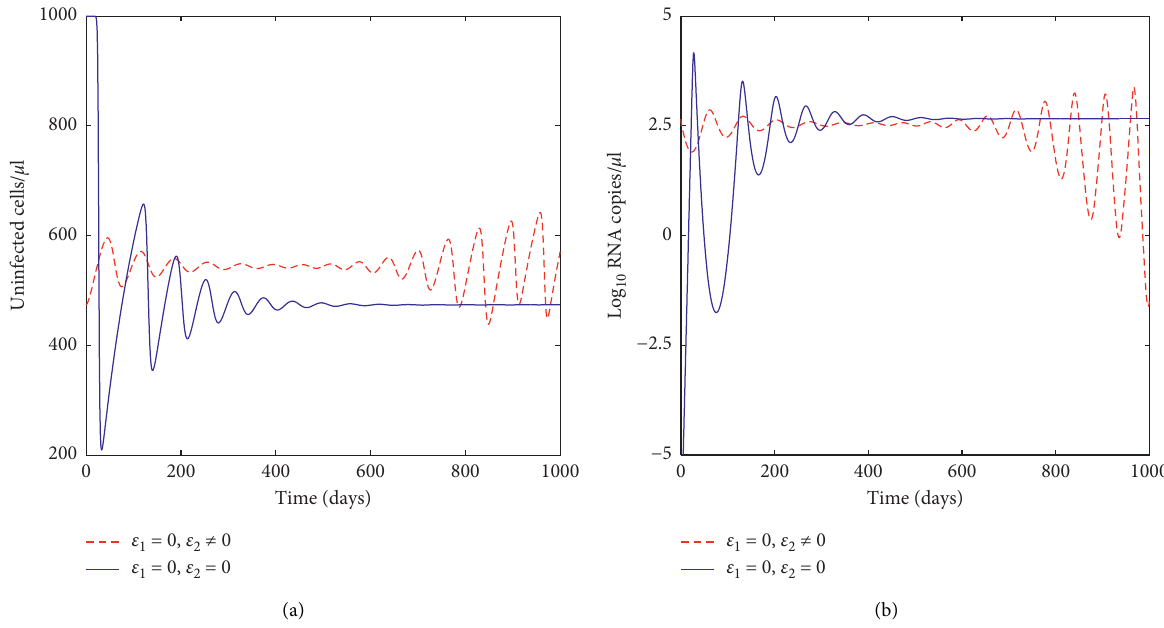
Figure 7: The level of (a) uninfected cells and (b) viral load corresponding to the optimal control strategy with ε without control; dashed lines: with